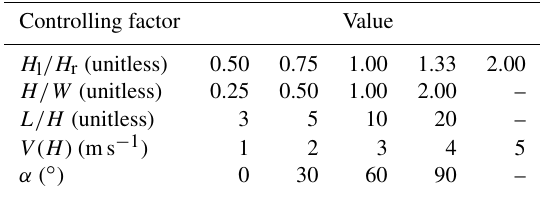
Table 1. Values of controlling factors used in the simulations. Controlling